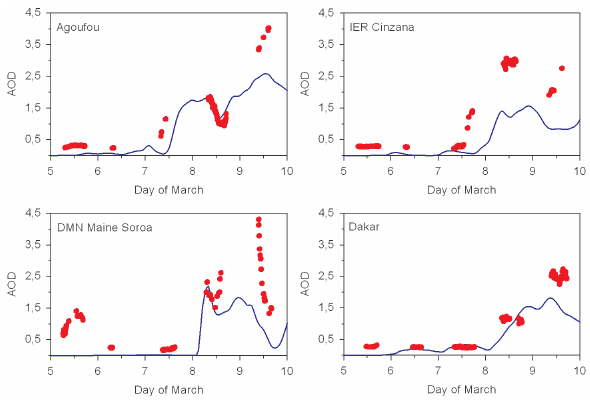
Figure 5: Observed visibility (red) and simulated AOD (blue) at 450 nm (run F) at Djanet and Hombori during 5-10 March 2006 (left) and corresponding observed and simulated 2 m temperature (right). Observations: red, run F: blue, run CTRL: green. Fig. 5. Observed visibility (red) and simulated AOD (blue) at 450nm (run F) at Djanet and Hombori during 5–10 March 2006 (left) and corresponding observed and simulated 2m temperature (right). Observations: red, run F: blue, run CTRL: